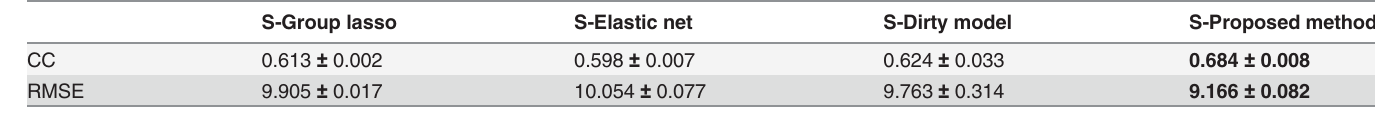
Table 4. Performance (mean ± standard deviation) comparison among all competing